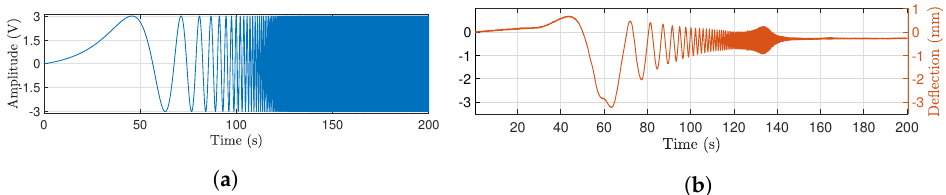
Figure 5. Example of experimental signals: ( a ) excitation signal applied to the first actuator for identification, ( b ) deflection measured on the third